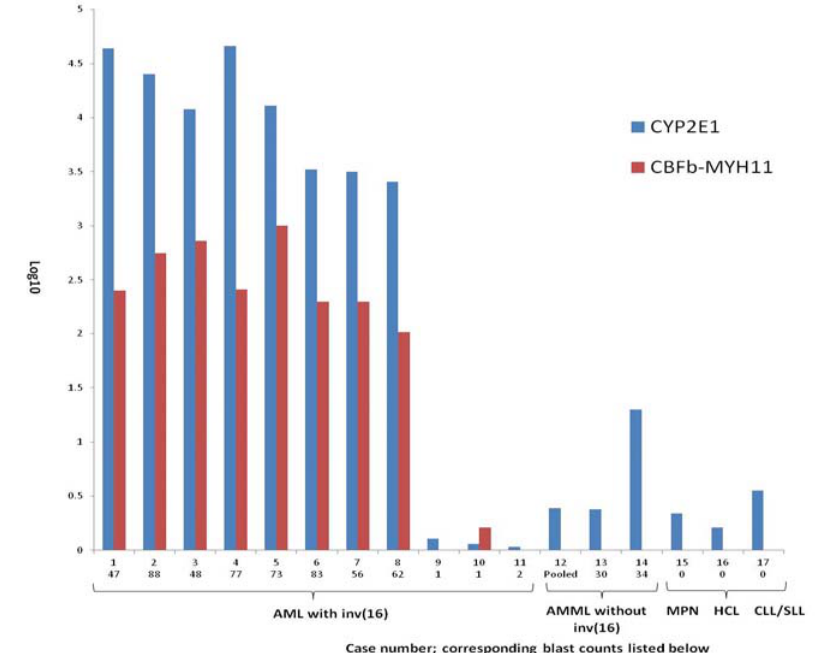
Figure 1. Comparison of expression levels of CYP2E1 mRNA in AML with inv(16), AML without inv(16), myeloproliferative neoplasm (MPN), hairy cell leukemia (HCL) and chronic lymphocytic leukemia/small lymphocytic lymphoma (CLL/SLL). The CYP2E1 expression levels (blue) are compared with CBF β -MYH11 transcript levels (maroon) in 11 cases of AML with inv(16), 2 cases of AMML without inv(16) and 1 case each of MPN, HCL and CLL/SLL. The BM blast counts are listed at the bottom of the figure. “Pooled” indicates the pooled RNA extracted from 20 BM cases of AML without inv(16).